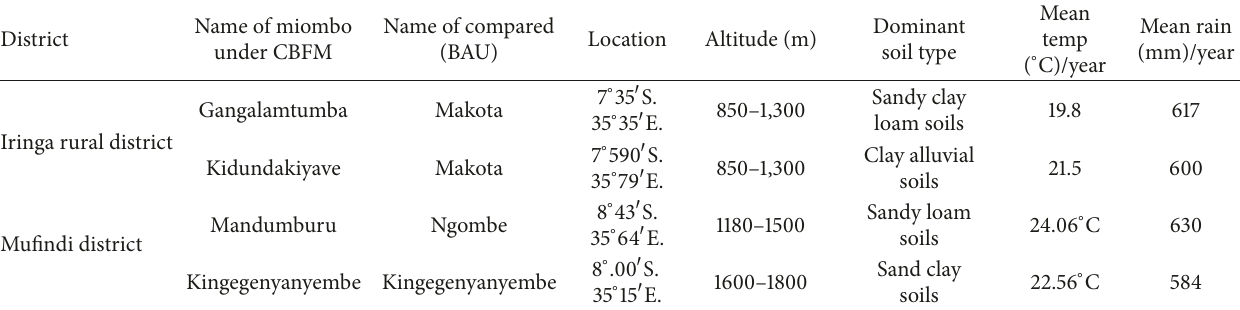
Table 2: Location of miombo woodlands, management practices, and its climatic characteristics.